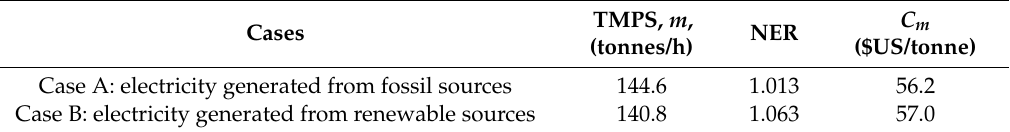
Table 6. TMPS feed rate for optimal NER and unit production cost for case A and case